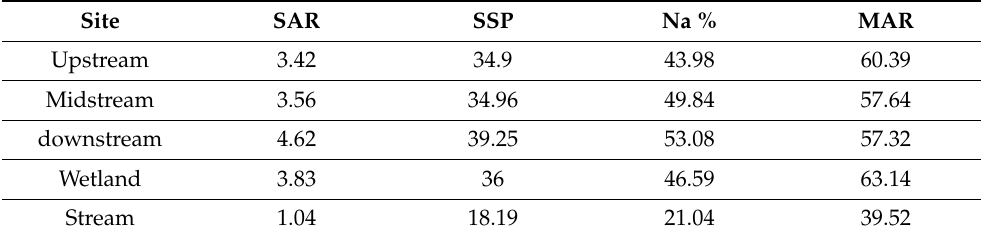
Table 2. SAR, SSP, Na%, and MAR for the wetland and